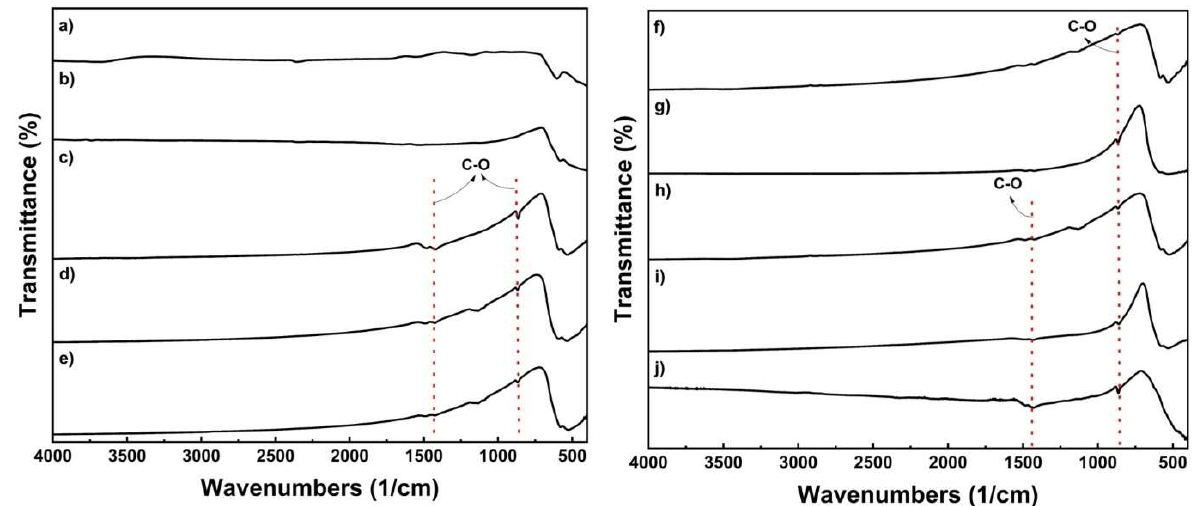
Figure 5. FTIR spectra of the sample; ( a ) LMO, ( b ) LCO, ( c ) NMC 333, ( d ) NMC424, ( e ) NMC442, ( f ) NMC523, ( g ) NMC532, ( h ) NMC 622, ( i ) NMC 811, and ( j ) NMC 811.